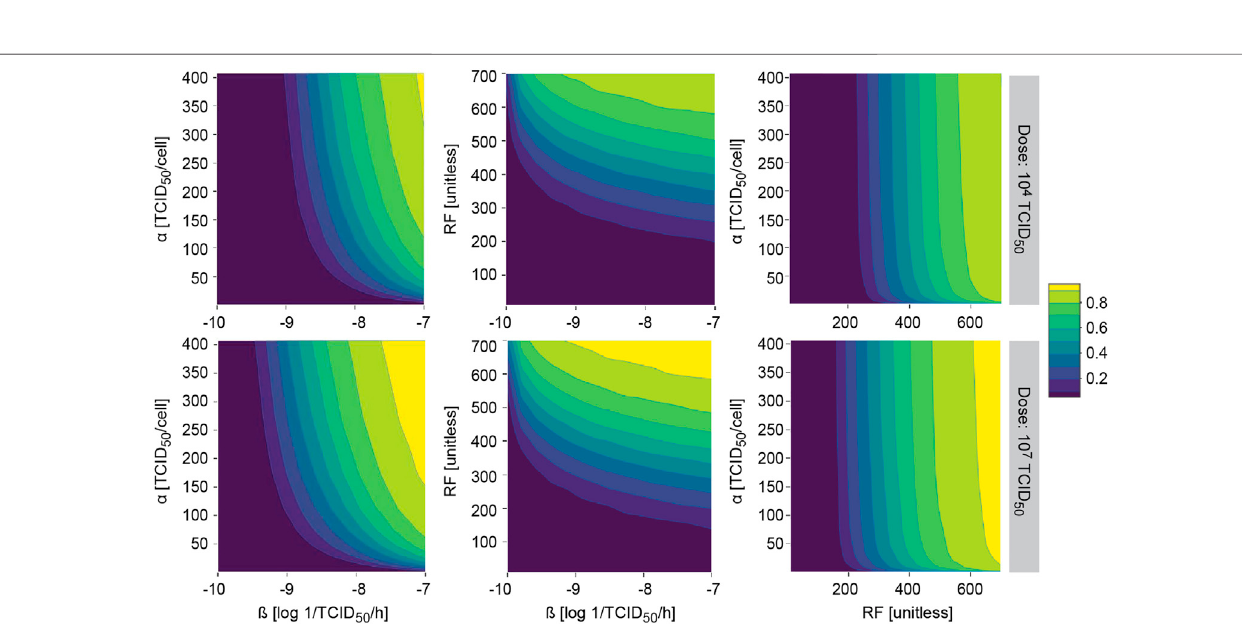
Frontiers in Pharmacology |